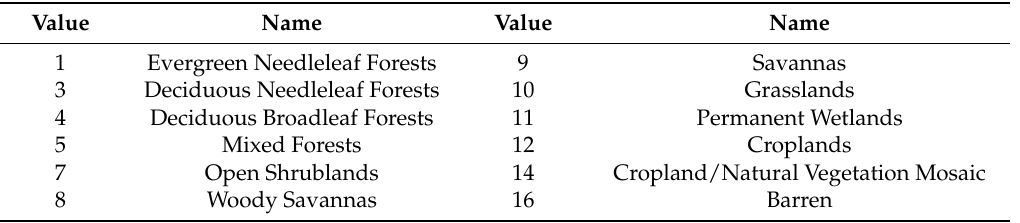
Table 2. The land cover type of Hulunbuir extracted from MODIS Land Cover Type Product